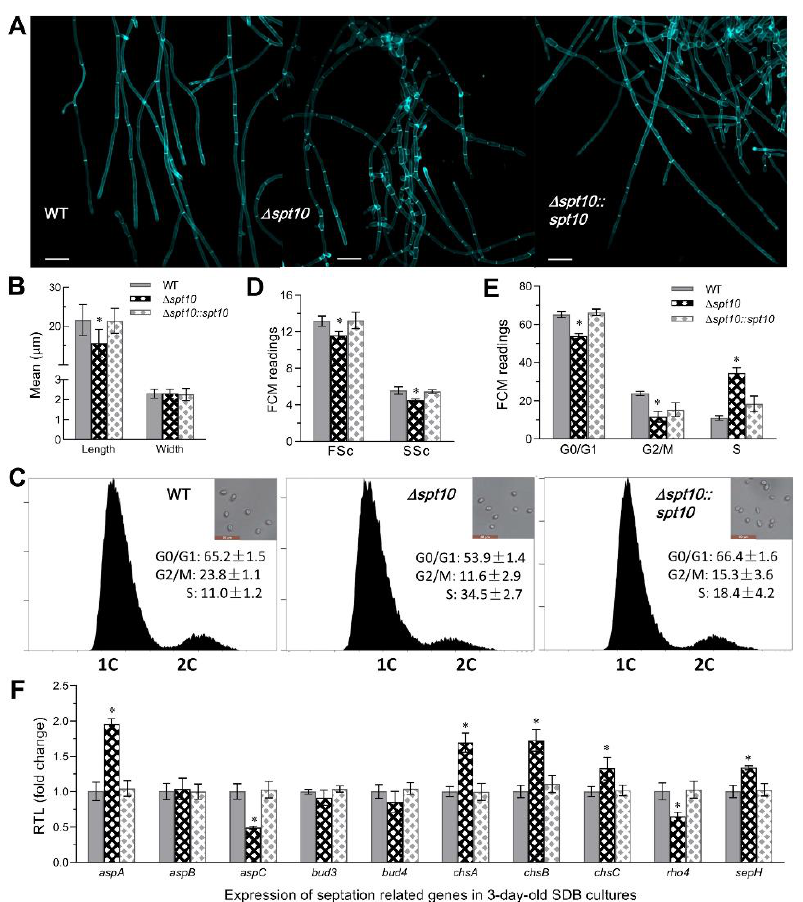
Figure 4. Impact of Spt10 deletion on hyphal septation and cell cycle in B. bassiana . ( A ) Microscopic images (scale bars: 20 µm) for the hyphal cells collected from 72-hour-old SDB cultures and stained with calcofluor white. ( B ) Mean cell length and width of hyphal cells stained with calcofluor white from each strain. ( C , E ) FACS analysis for distribution of cell cycle phases of blastspores collected from the liquid cultures of 10 6 conidia ml –1 NLB incubated for 3 days at 25 °C. ( D ) FACS analysis for cell size (FSc) and density (SSc) of blastspores collected from 3-day-old NLB cultures. ( F ) Relative transcript levels of 10 septation-related genes in the 72-hour-old SDB cultures. Asterisked bar in each three-bar group differs significantly from those unmarked (Tukey's HSD, * indicates p < 0.05). Error bars: SD from three replicates.